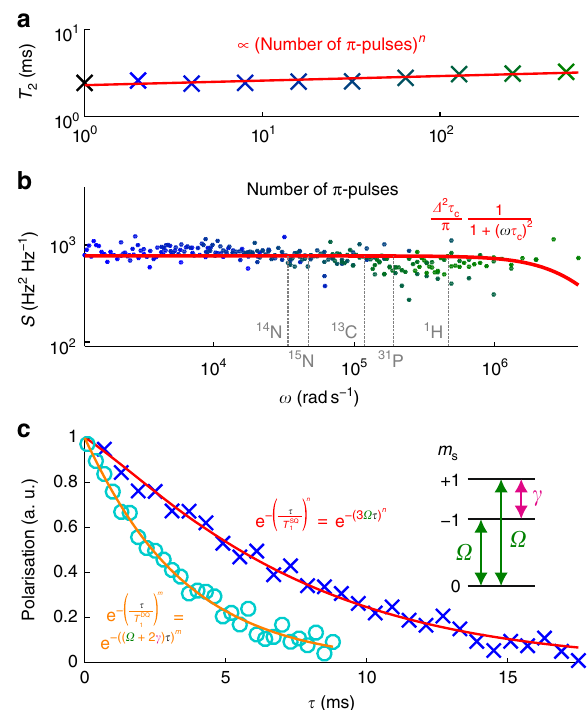
Fig. 4 Noise analyses. a T 2 vs number of π -pulses from measurements with Carr – Purcell – Meiboom – Gill sequences (datum with black cross for Hahn- echo, data with blue/green crosses for 2 1 – 9 π -pulses, exponential fi t with red line, exponent n = 0.05 ± 0.01). b Noise spectrum extracted from the same measurements as in a (starting from 2 1 pulses, data with blue/green dots, Lorentzian fi t with red line, correlation time τ c fi xed to represent the highest probed frequency). The Larmor frequencies of several nuclear spins are indicated (grey dashed lines); B = 1.8 mT. c Single quantum (data with ≈ 7.4 ms) blue crosses, exponential-decay fi t with red line, measured T SQ 1 and double quantum (data with cyan circles, exponential-decay fi t with ≈ 3.4 ms) T orange line, measured T DQ 1 measurements for 1